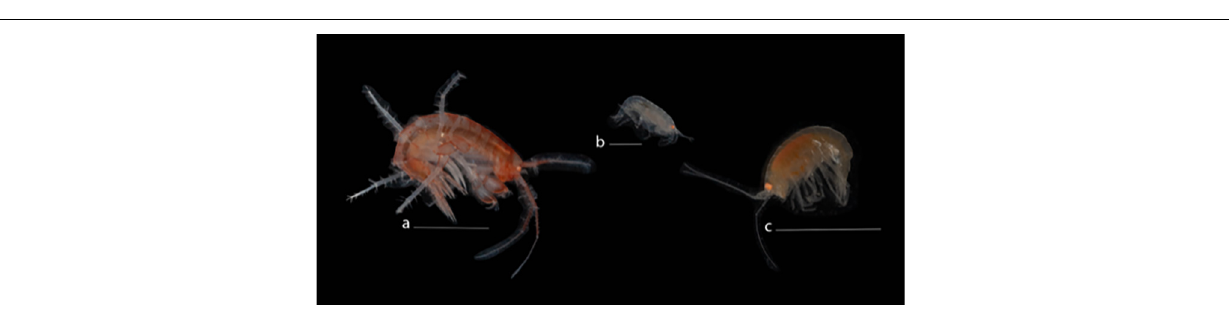
FIGURE 9 | Photographic plate demonstrating examples of the Amphipoda (a) Ampithoidae sp. (5 mm scale bar), (b) Stenothoidae sp. (1 mm scale bar), and (c) Calliopiidae sp. (5 mm scale bar) from ROV